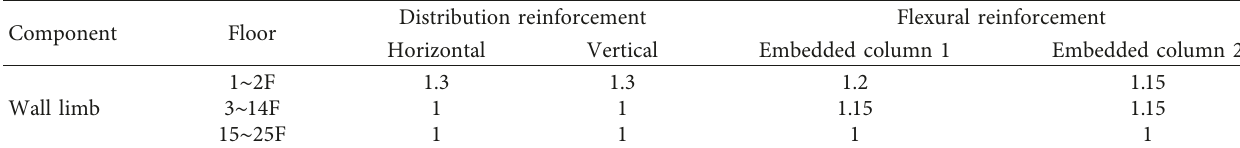
/ ρ in wall limb. O N